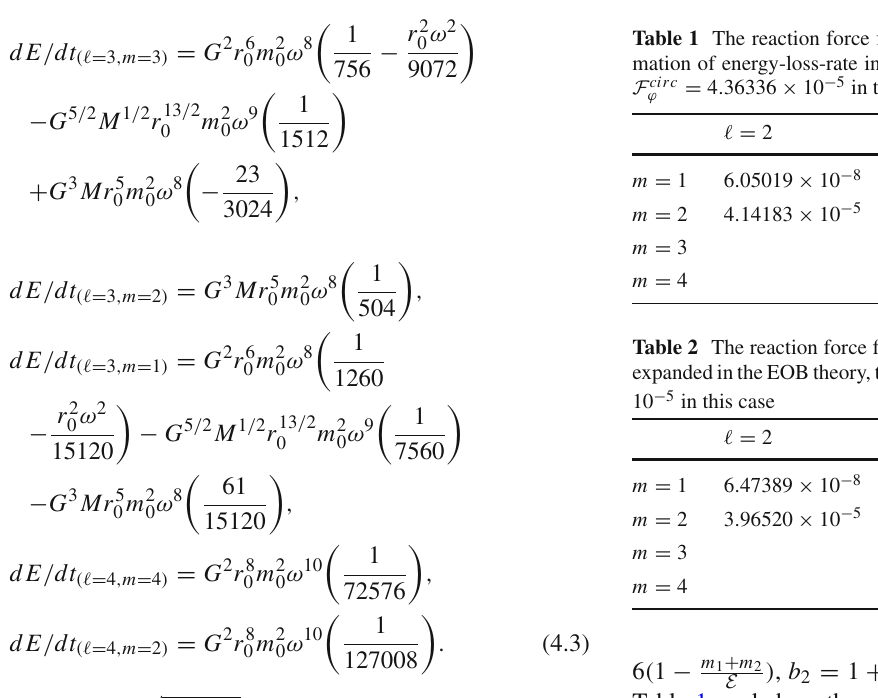
Table 1, and show the reaction force for the case that Z (cid:7) m does not expanded in Table